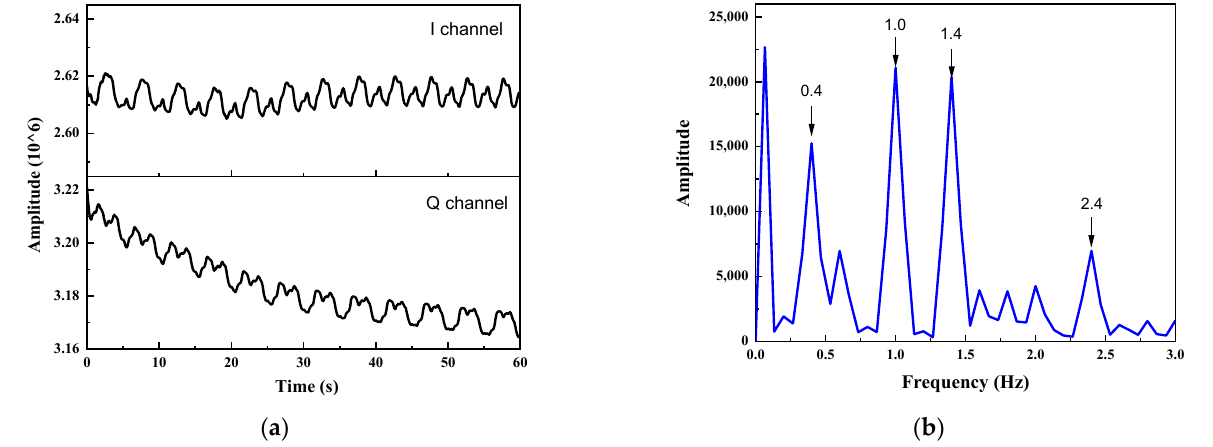
Figure 6. The moving board maintain a mixed sinusoidal motion with amplitude of 2 mm and 0.2 mm, and frequency of 0.2 Hz and 1.2 Hz, respectively: ( a ) the time domain diagrams of the two-channel data received by the radar; ( b ) the spectrum distribution diagrams of 15–30 s.